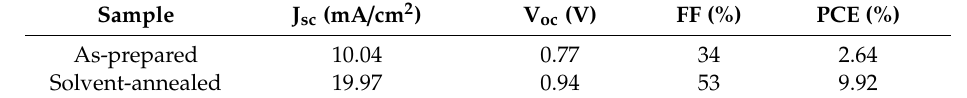
Figure 7. The J-V curves of as-prepared and solvent-annealed MAPbI 3 solar cells. Table 2. The performance of the as-prepared and solvent-annealed MAPbI 3 solar cells.